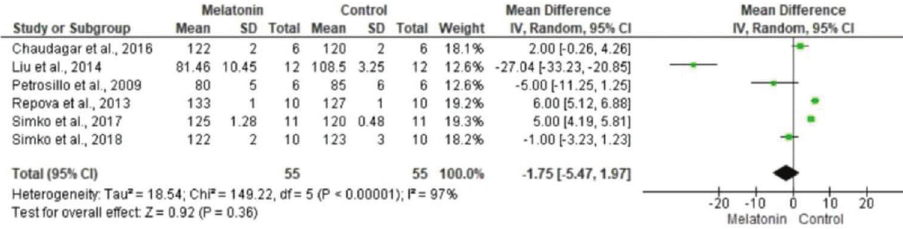
Figure 3b - Metanalysis of systolic blood pressure (mmHg).